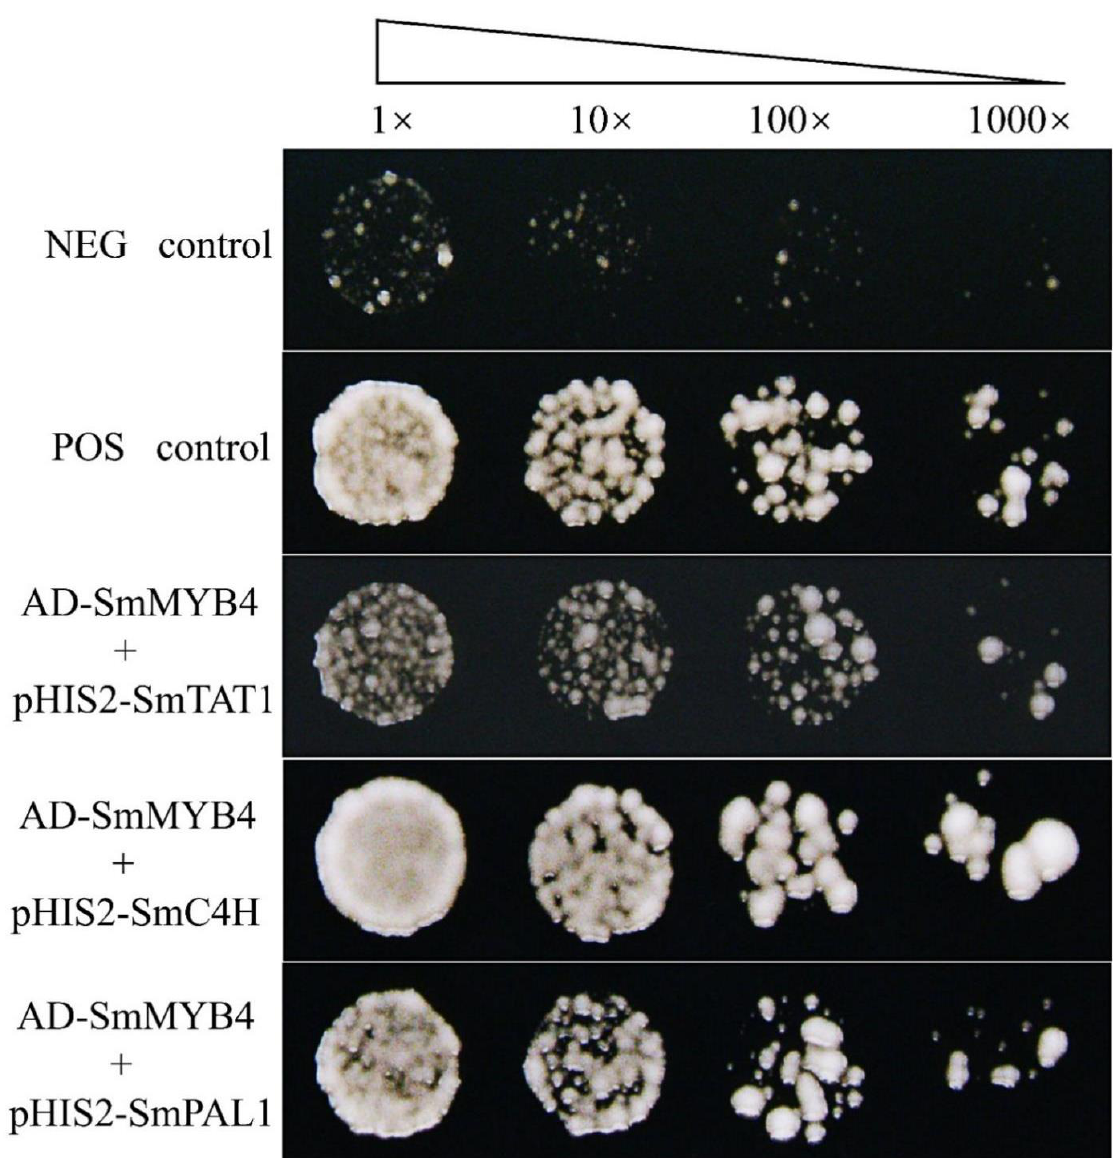
Figure 6. SmMYB4 binds the promoters of SmTAT1, SmC4H, and SmPAL1. The first and second rows represent the negative and positive controls, respectively. NEG control: pGADT7 + p53HIS2; POS control: pGADT7-p53 + p53HIS2.